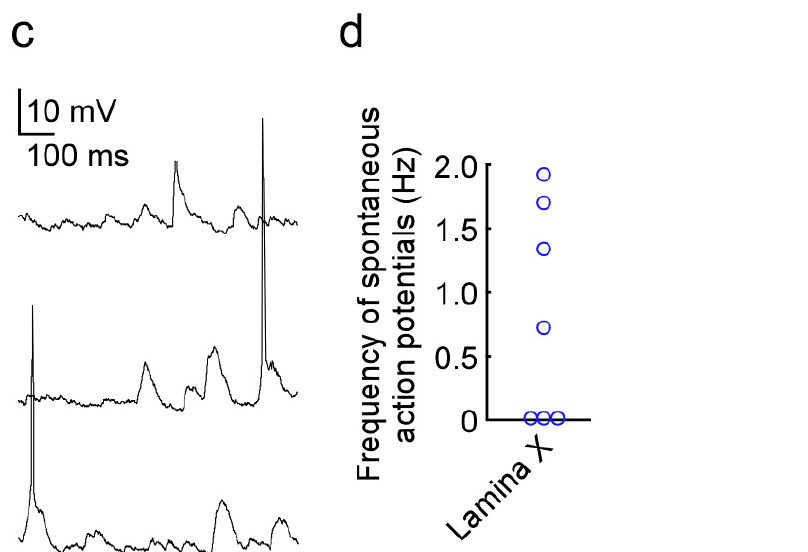
Figure 3. In vivo patch-clamp recording from lamina X neurons in the rat spinal cord. ( a ) Representative trace of spontaneous excitatory postsynaptic currents (sEPSCs) recorded from a lamina X neuron. ( b ) Summary showing the frequency (left) and the amplitude (right) of sEPSCs. ( c ) Under current clamp condition, representative trace of spontaneous excitatory postsynaptic potentials and action potentials recorded from a lamina X neuron. ( d ) Summary showing the frequency of spontaneous action potentials. Int. J. Mol. Sci. 2021 , 22 , x FOR PEER REVIEW